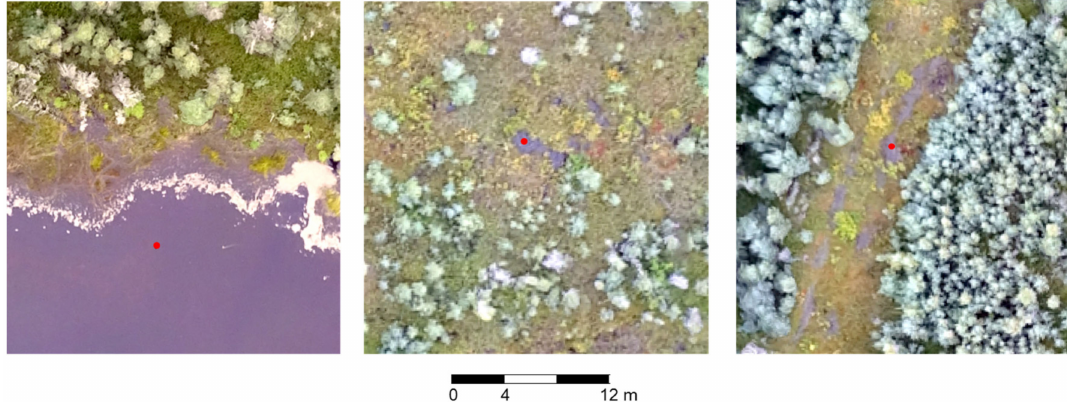
Figure 4. Examples of samples (red points) in open water (blue) from across the study area. In order to reduce the bias of using object center points for interpolation, we selected on sample point per 50-m 2 section to represent water